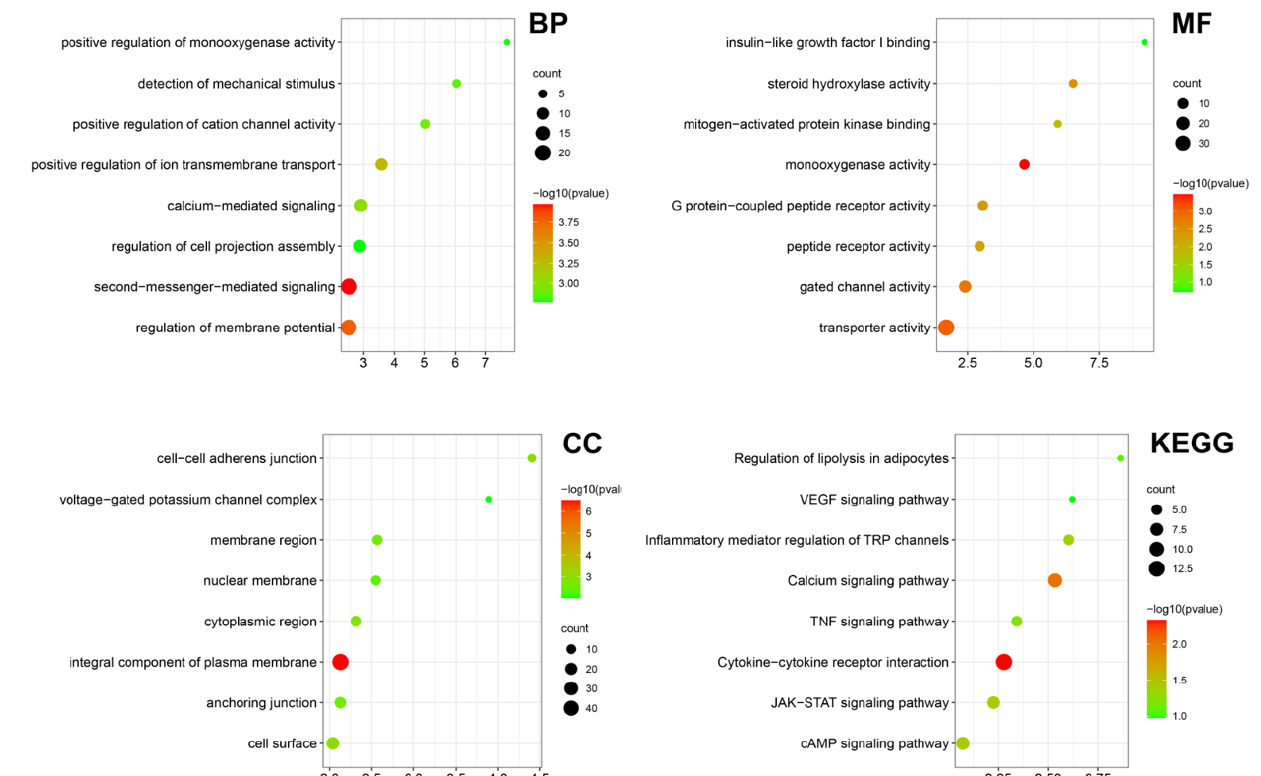
Figure 5. Transcriptome bioinformatic analysis of LCs with and without LIPUS stimulation. The Gene Ontology (GO) analysis including biological process (BP), cellular component (CC), and molecular function (MF) and Kyoto Encyclopedia of Genes and Genomes (KEGG) analysis according to the DEGs between the LIPUS group and normal control are shown as a bubble diagram. A gradient of red to green indicates low to high p values in the bubble diagram and the size of the bubbles indicates the count of enriched DEGs for each GO term.